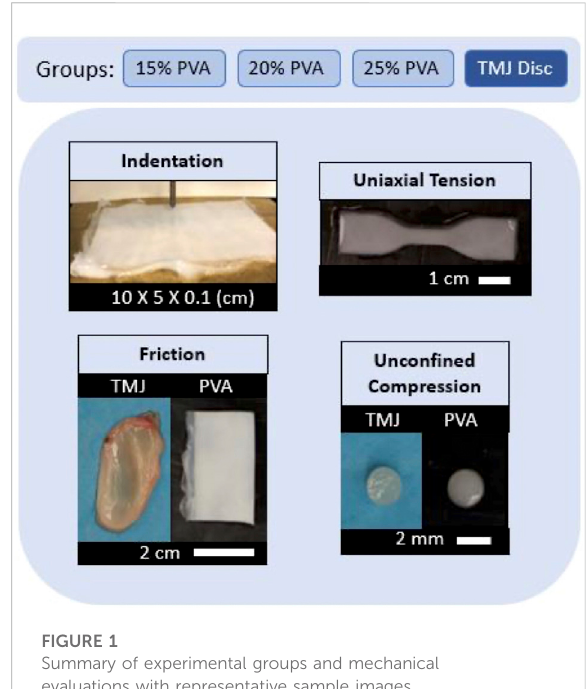
Summary of experimental groups and mechanical evaluations with representative sample